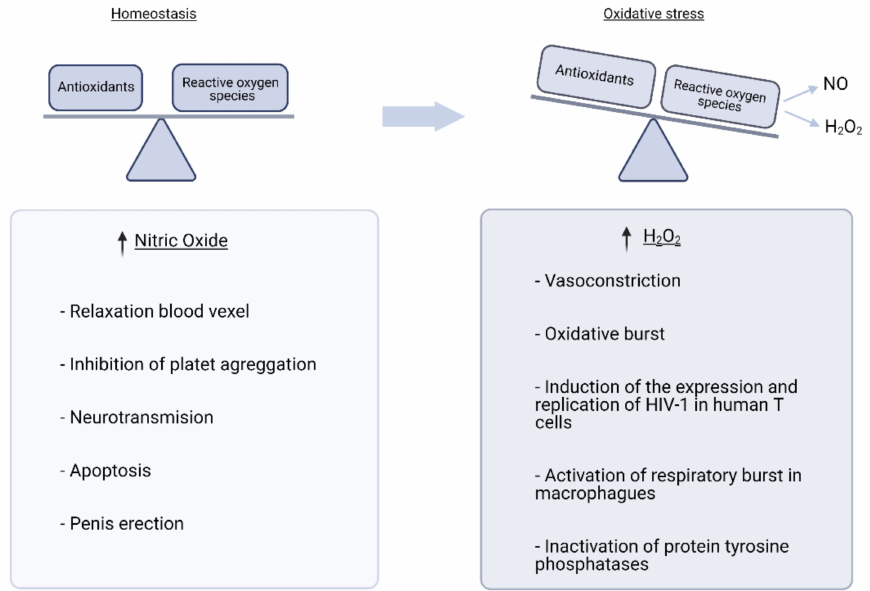
Figure 1. Clinical relevance of reactive oxygen species. Reactive oxygen species (ROS) have numerous functions involved in maintaining cellular homeostasis, such as those shown in the figure. However, when ROS levels increase, these functions are altered by dysregulation of signalling